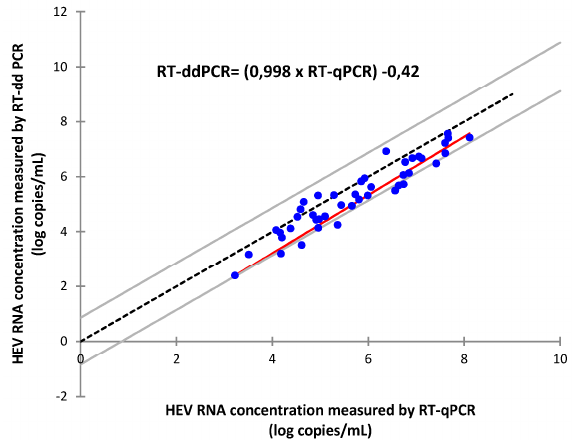
Figure 1. Passing ‐ Bablock regression analysis of hepatitis E virus (HEV) RNA concentrations Figure 1. Passing-Bablock regression analysis of hepatitis E virus (HEV) RNA concentrations determined by reverse transcriptase droplet digital PCR (RT ‐ ddPCR) and reverse transcriptase determined by reverse transcriptase droplet digital PCR (RT-ddPCR) and reverse transcriptase quantitative PCR (RT ‐ qPCR) assays ( n = 43). The red line represents the Passing ‐ Bablock regression quantitative PCR (RT-qPCR) assays ( n = 43). The red line represents the Passing-Bablock regression line, the dashed line represents the identity line and grey lines represent the confidence interval for the regression line. Dots represent HEV RNA concentrations measured by RT-qPCR and RT-ddPCR for each